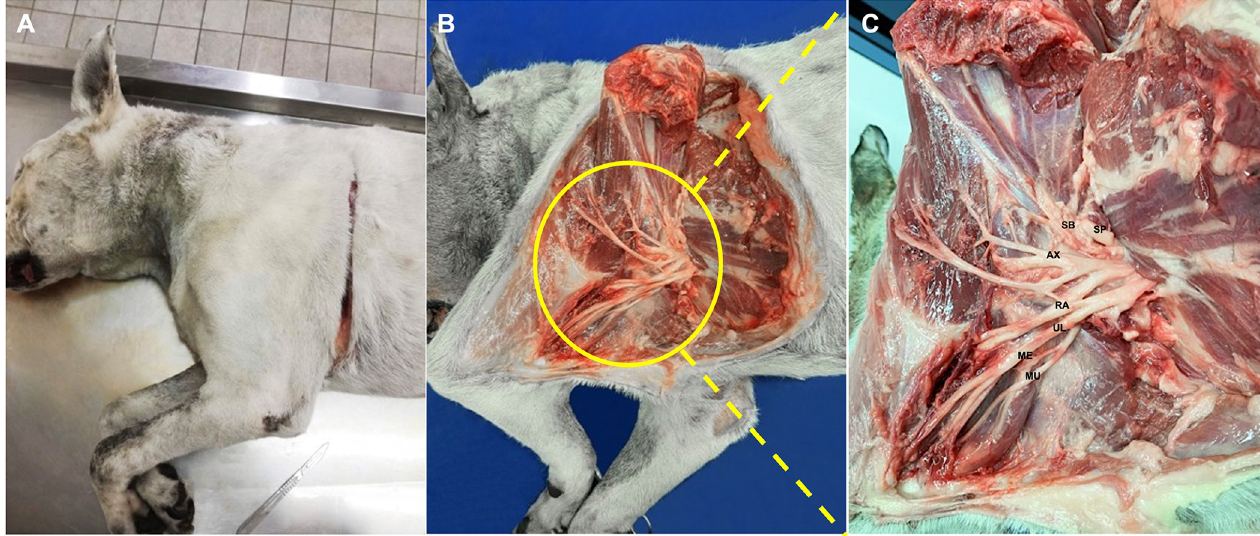
Fig 1. Anatomical dissection. (A) An incision involving the skin, the subcutaneous tissue, the thoracic portion of the trapezius and the latissimus dorsi muscles was performed following the caudal limit of the triceps region, proximally following the dorsal margin of the scapula, and distally up to the axillary fold. (B) The forelimb was overturned cranially to expose the brachial plexus at the level of the axillary space. (C) The suprascapular (SP), the subscapular (SB), the axillary (AX), the radial (RA), the ulnar (UL), the median (ME) and the musculocutaneous (MU) nerves were then identified.